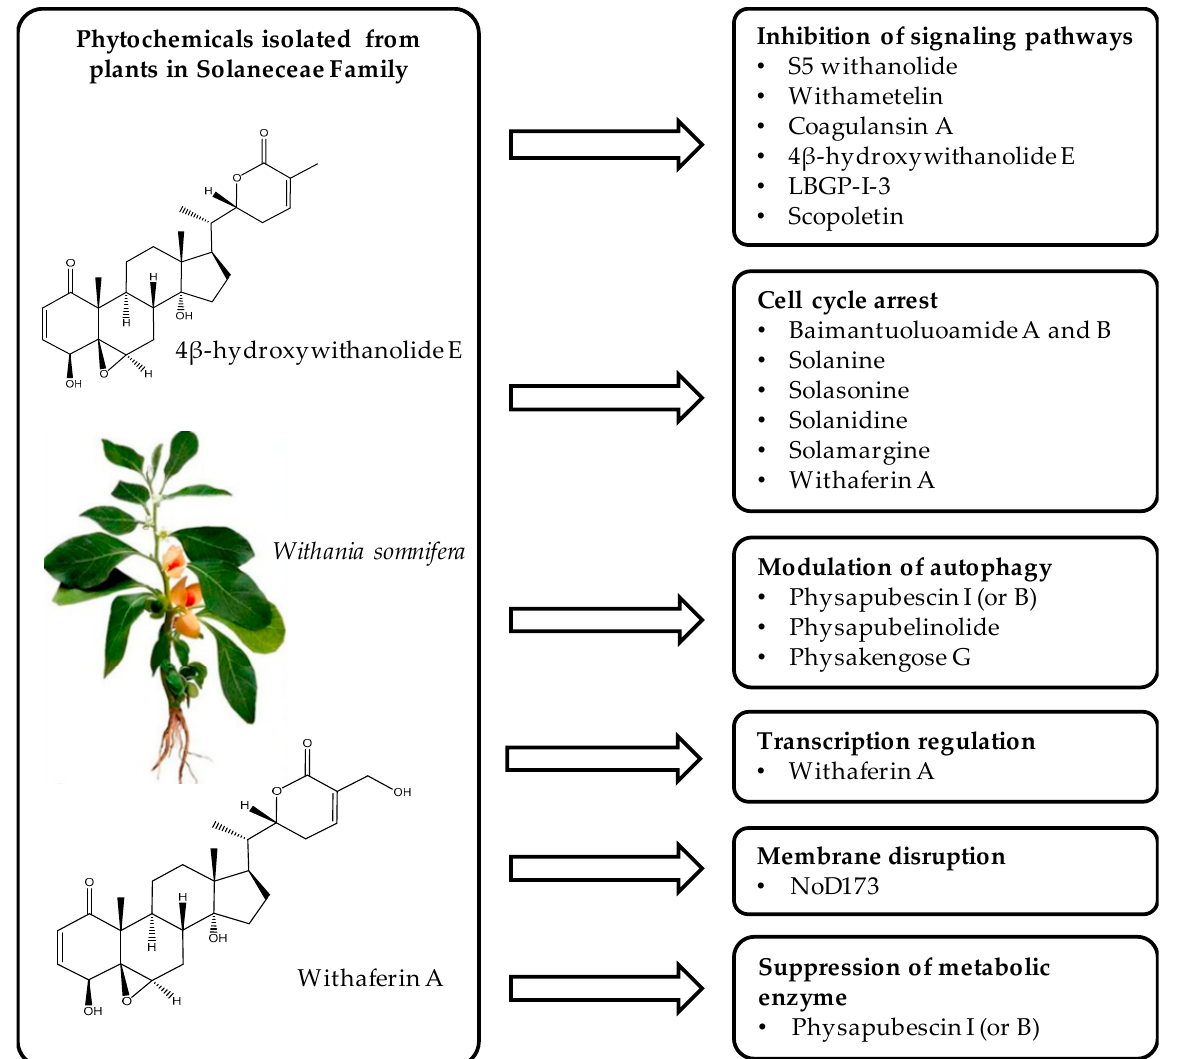
Figure 1. Graphic summary of anticancer mechanisms by phytochemicals isolated from various species in the Solanaceae plant family. A representative species, Withania somnifera , is shown with two of its secondary metabolites. The image of Withania somnifera was taken from [13], with copyright permission issued by Elsevier and Copyright Clearance Center, under license number 5140970100267.